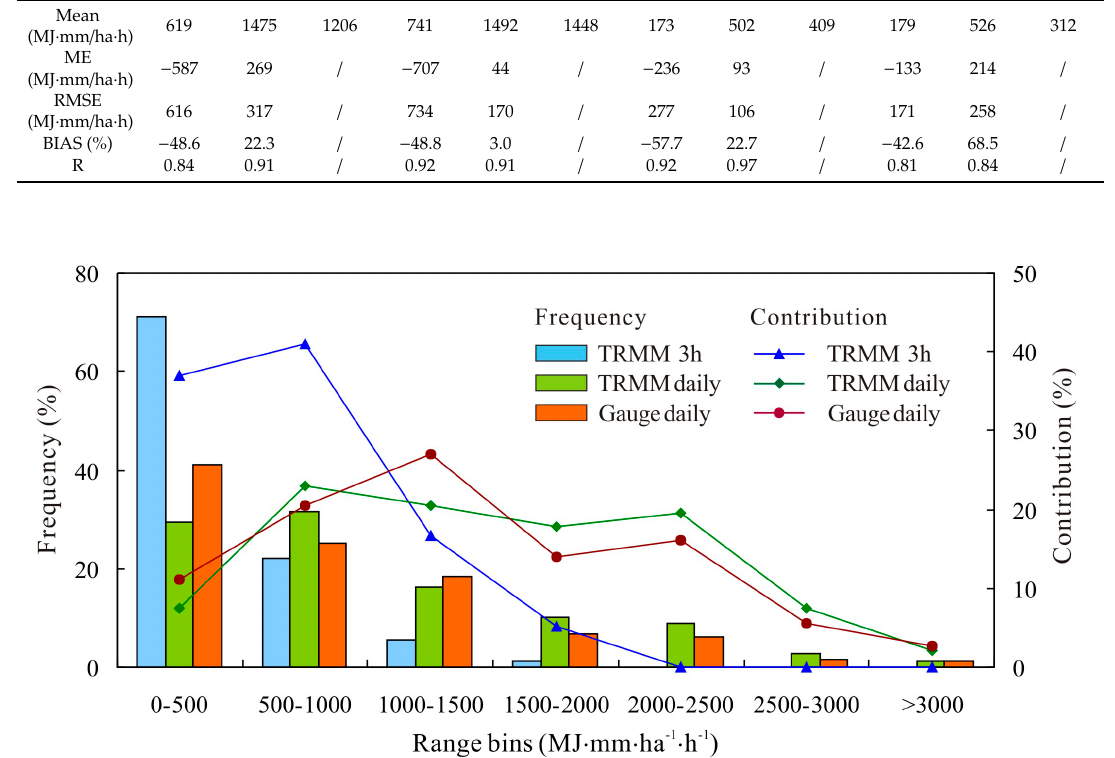
Figure 5. Distribution of monthly RE values in different categories and their proportion to annual RE.